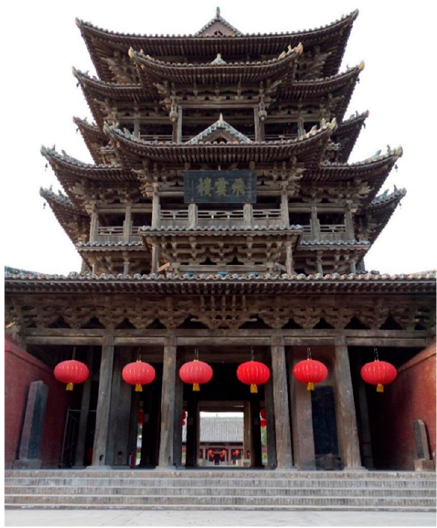
Figure 1. Feiyun Wood Pavilion.